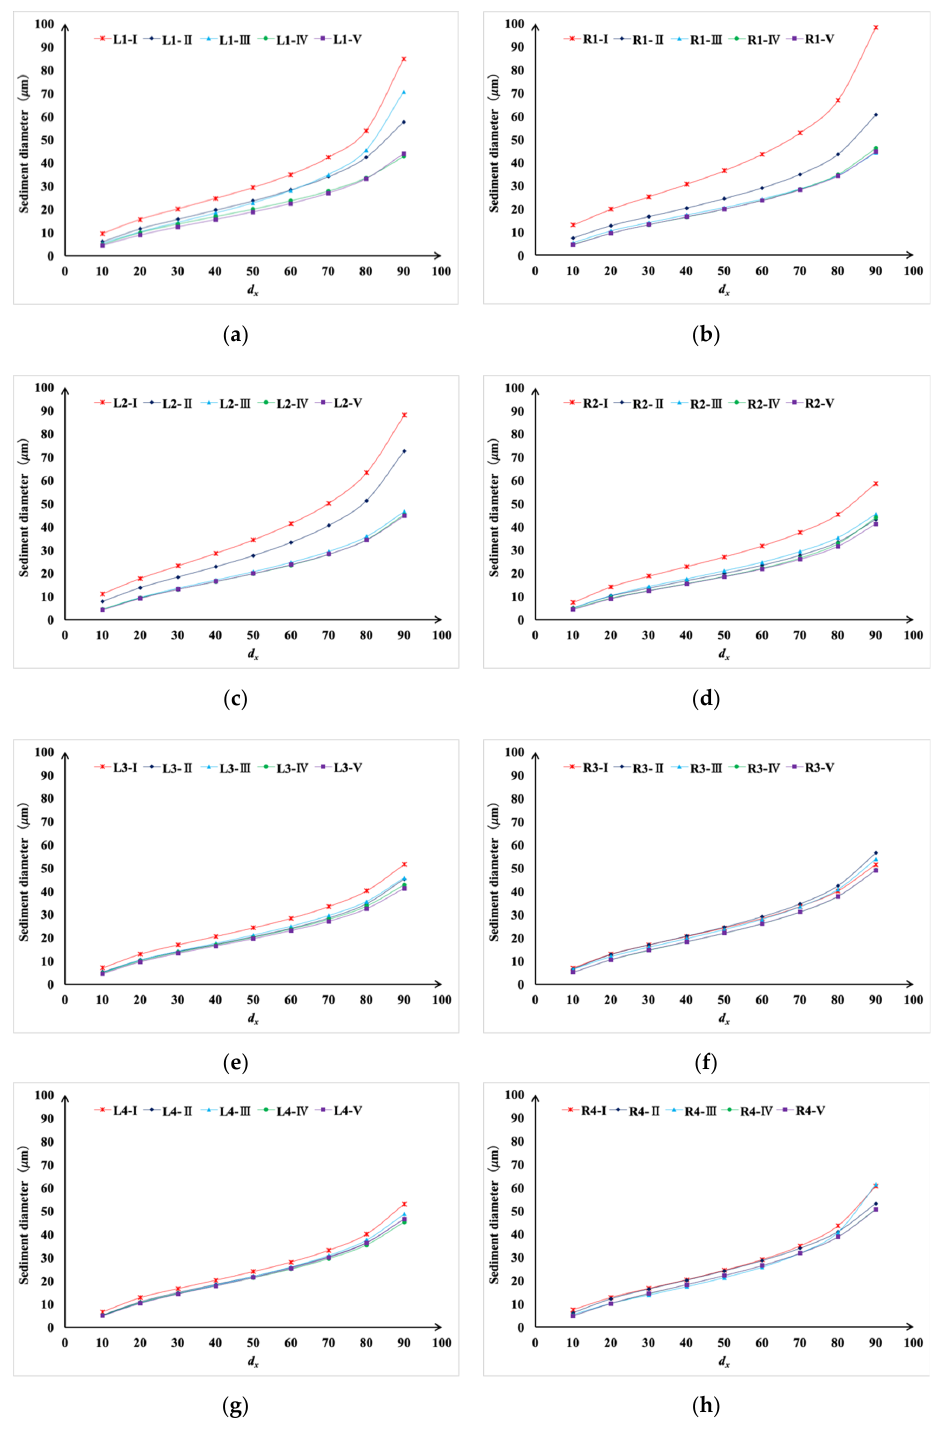
Figure 10. Sediment size grading distribution at different locations in the settlement area with inclined tubes (ISA): ( a ) tube L1, ( b ) tube R1, ( c ) tube L2, ( d ) tube R2, ( e ) tube L3, ( f ) tube R3, ( g ) tube L4 and ( h ) tube R4. (The horizontal ordinate title d x indicated the characteristic particle size.)